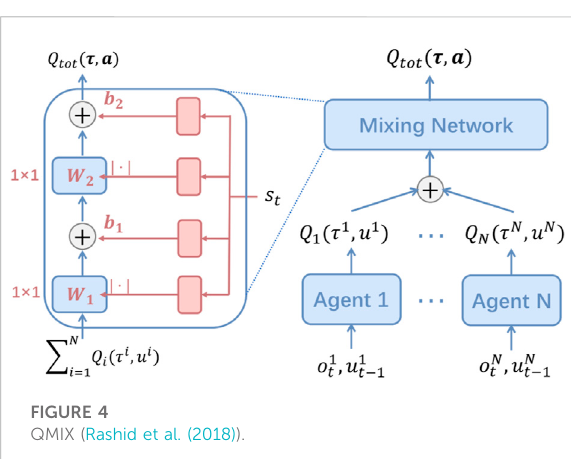
FIGURE 2 Agents in a multi-agent reinforcement learning (MARL) environment